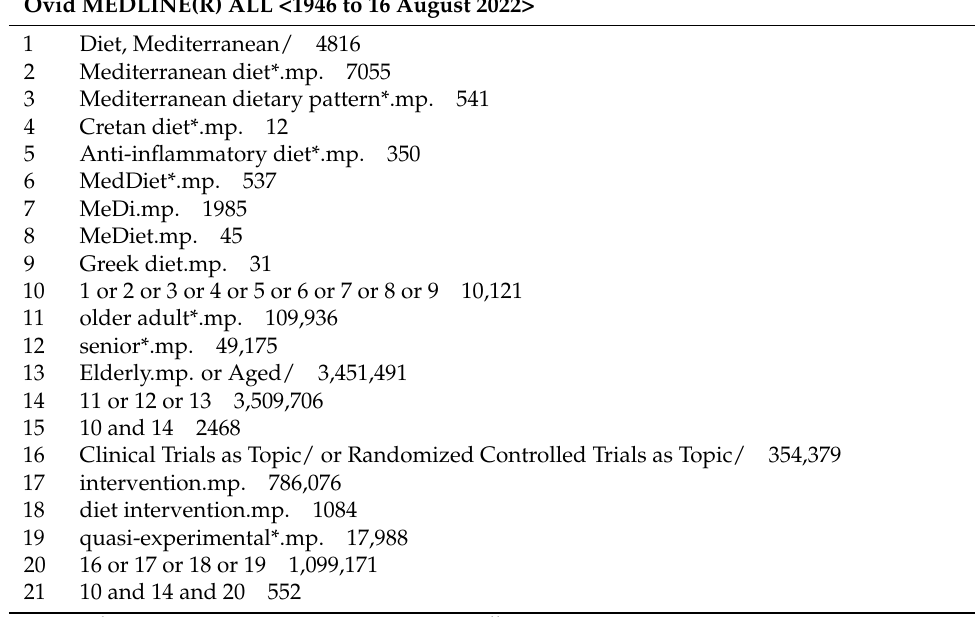
Table 1. Search strategy for the scoping review of Mediterranean diet interventions among older adults: database—Ovid MEDLINE.